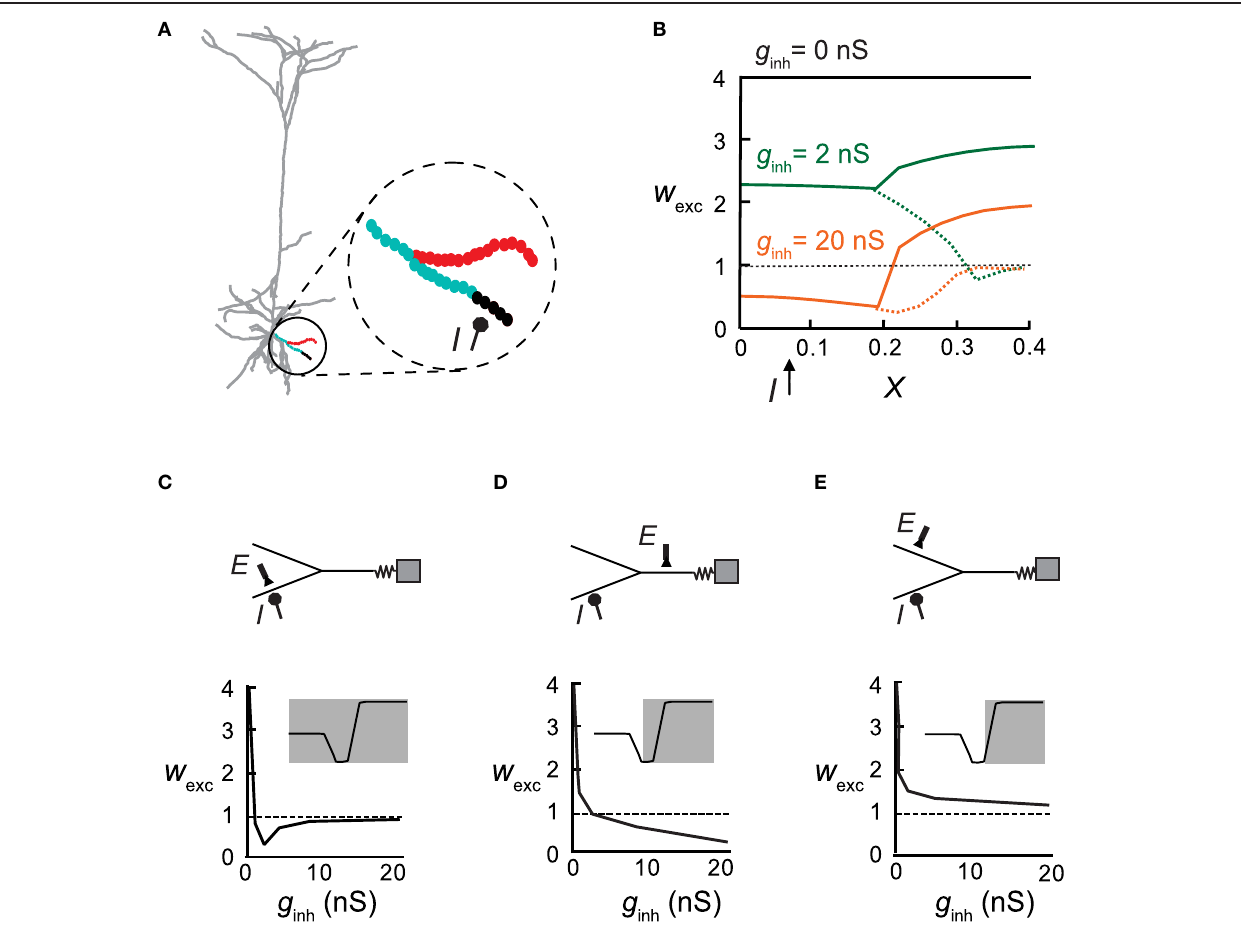
FIGURE 5 | An inhibitory synapse differentially impacts plasticity in different adjacent branches. (A) Excitatory synapses (circles in inset) were activated at 10Hz on a distal basal bifurcating branch (parent and two daughter branches) in the pyramidal cell model. Inhibition ( I ) on one of the daughter branches (at X = 0 . 08 with g inh = 5nS) generated a local protected region (black) whereas LTD ensued at the more proximal region and at the father branch (cyan). Synapses on the sister branch were strengthened (LTP, red). (B) Synaptic weights in all three branches versus electrical distance of